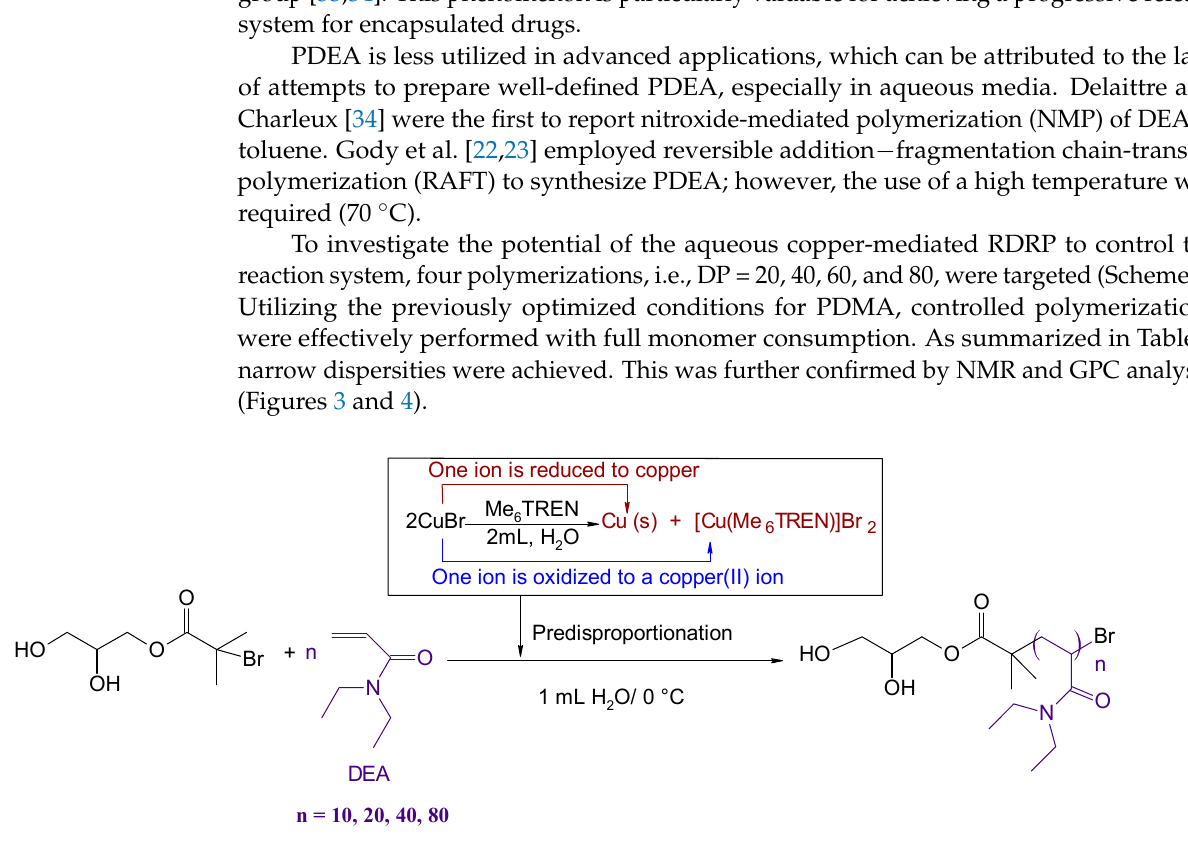
Scheme 3. Synthesis of PDEA (DP = 10, 20, 40, 80) by Cu(0)-mediated polymerization in water at 0° C via prior dispropor- tionation of copper bromide. Conditions: [WSI]:[copper]:[ligand] = 1:0.4:0.4. Table 2. Summary of characteristics of different DPs of diethylacrylamide (DEA) by Cu(0)-mediated polymerization under various conditions.